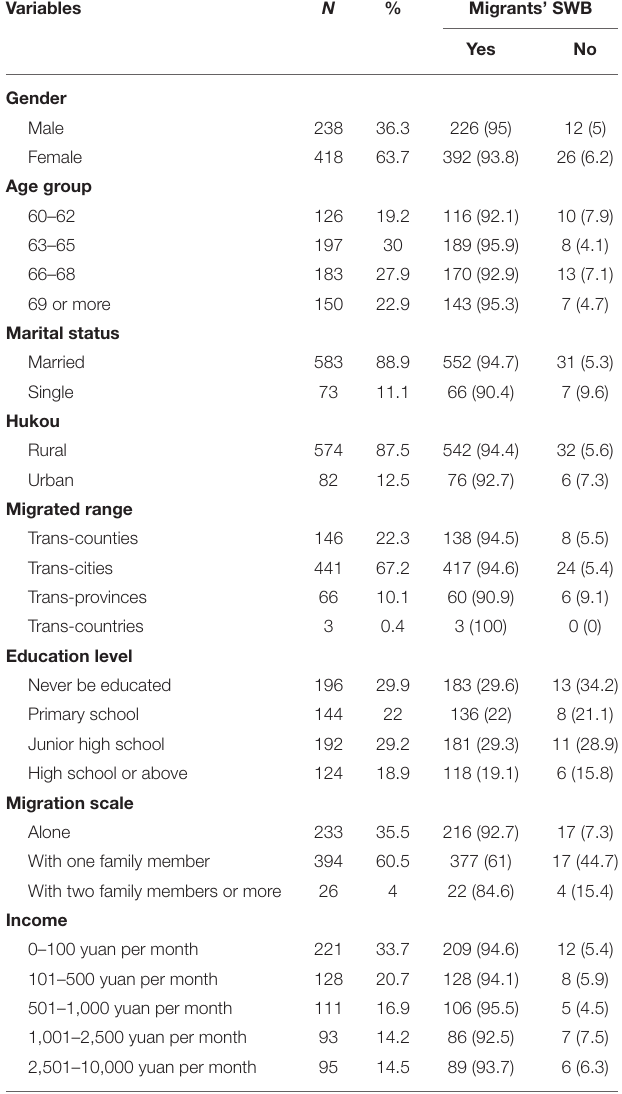
TABLE 1 | Social demographic characteristics among migrant elderly following